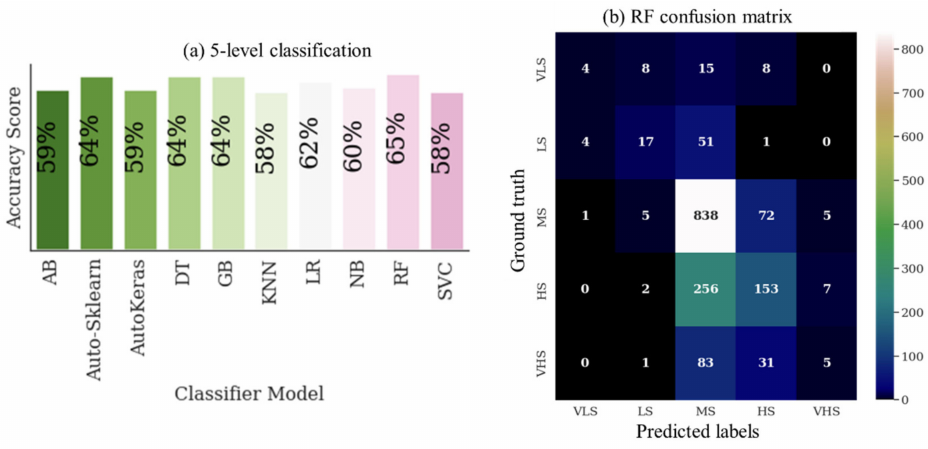
Figure 8. ( a ) Five-level accuracy performance. ( b ) Confusion matrix for